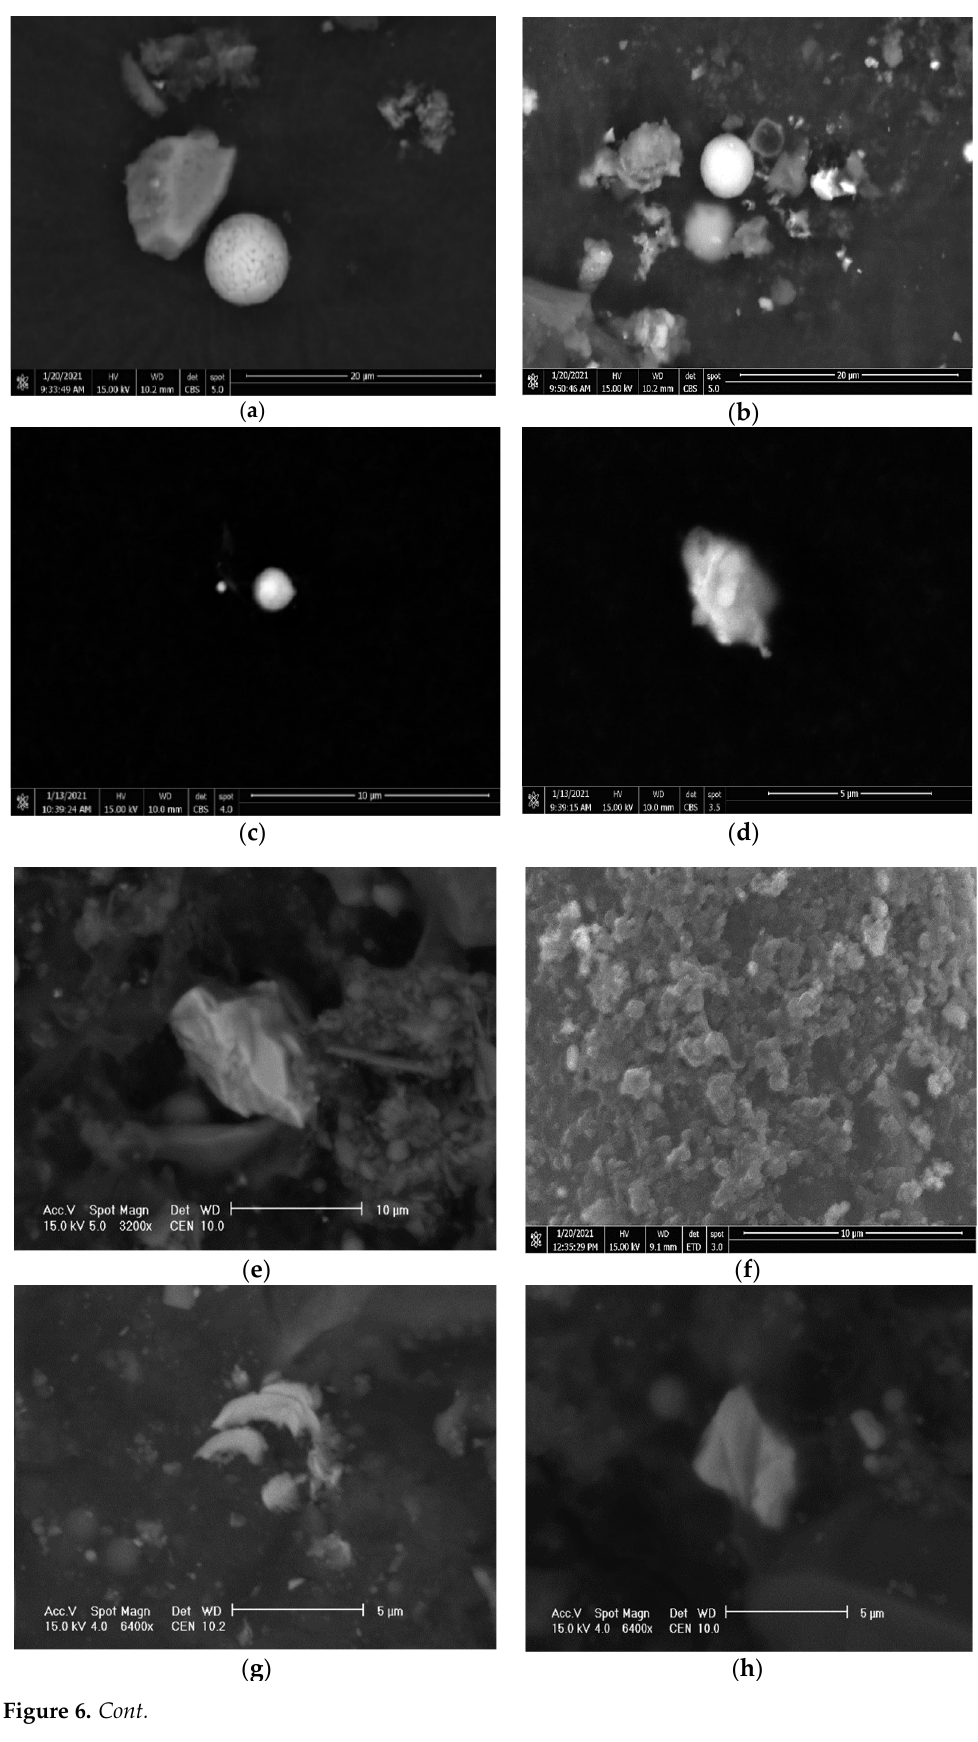
Figure 5. Surface area of grains (<10 µm) of different components of Pszczyna—Piasek dusts. Figure 6a–f presents the mineral composition of selected atmospheric dust particles.